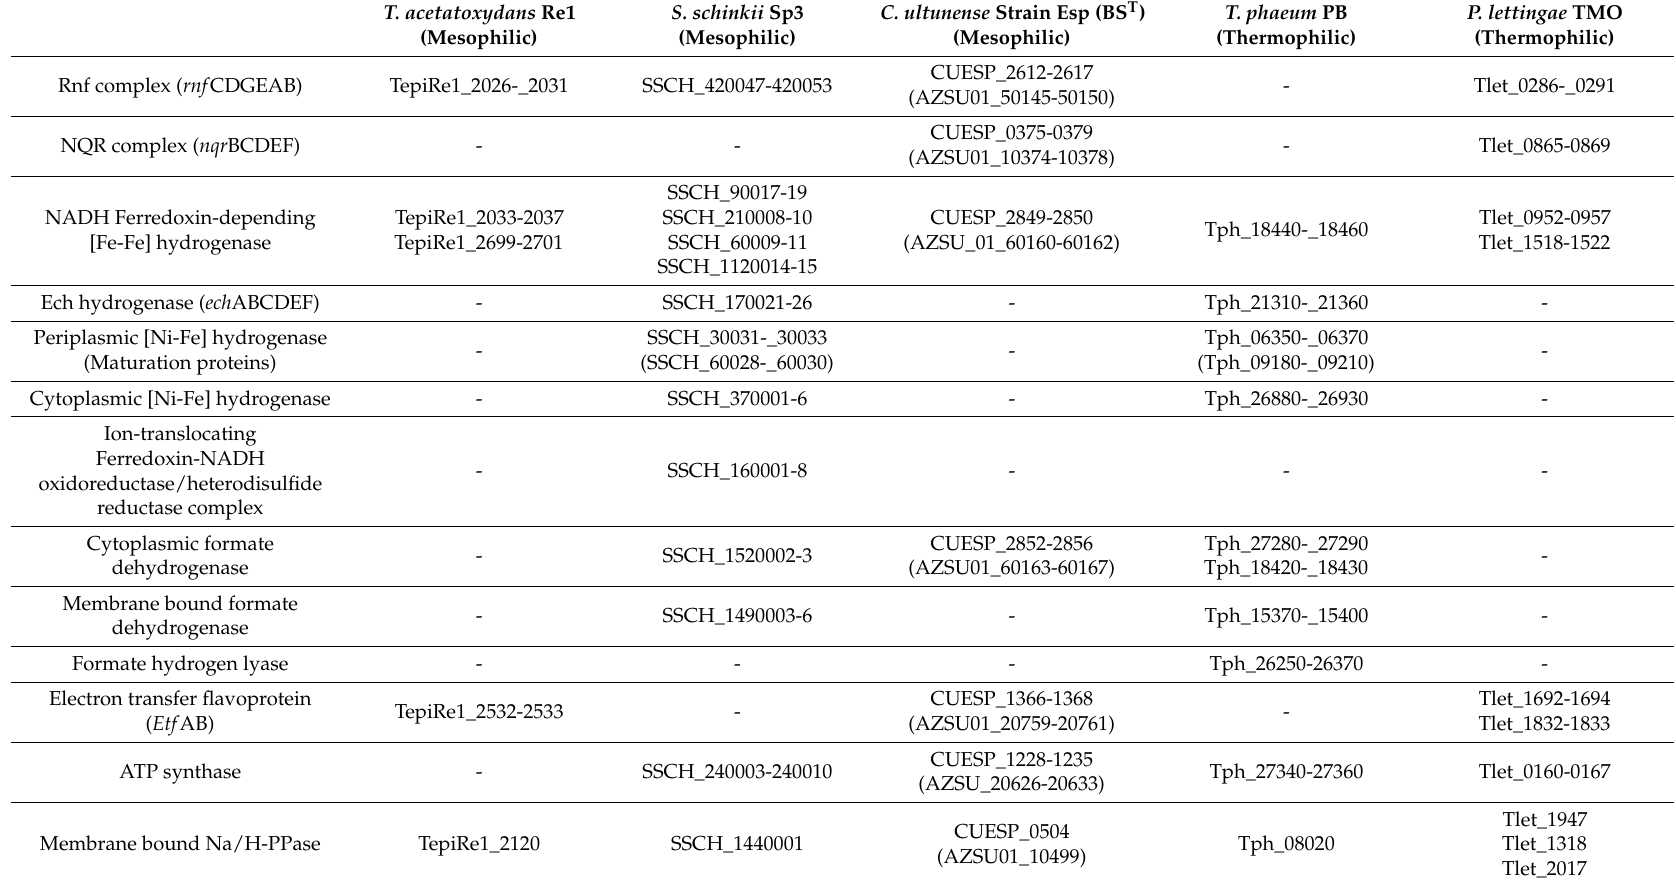
Table 3. Energy-conserving systems and related proteins predicted for the SAOB C. ultunense strain Esp, C. ultunense strain BS T , T. acetatoxydans strain Re1, Th. Phaeum strain PB, P. lettingae strain TMO, and S. schinki strain Sp3